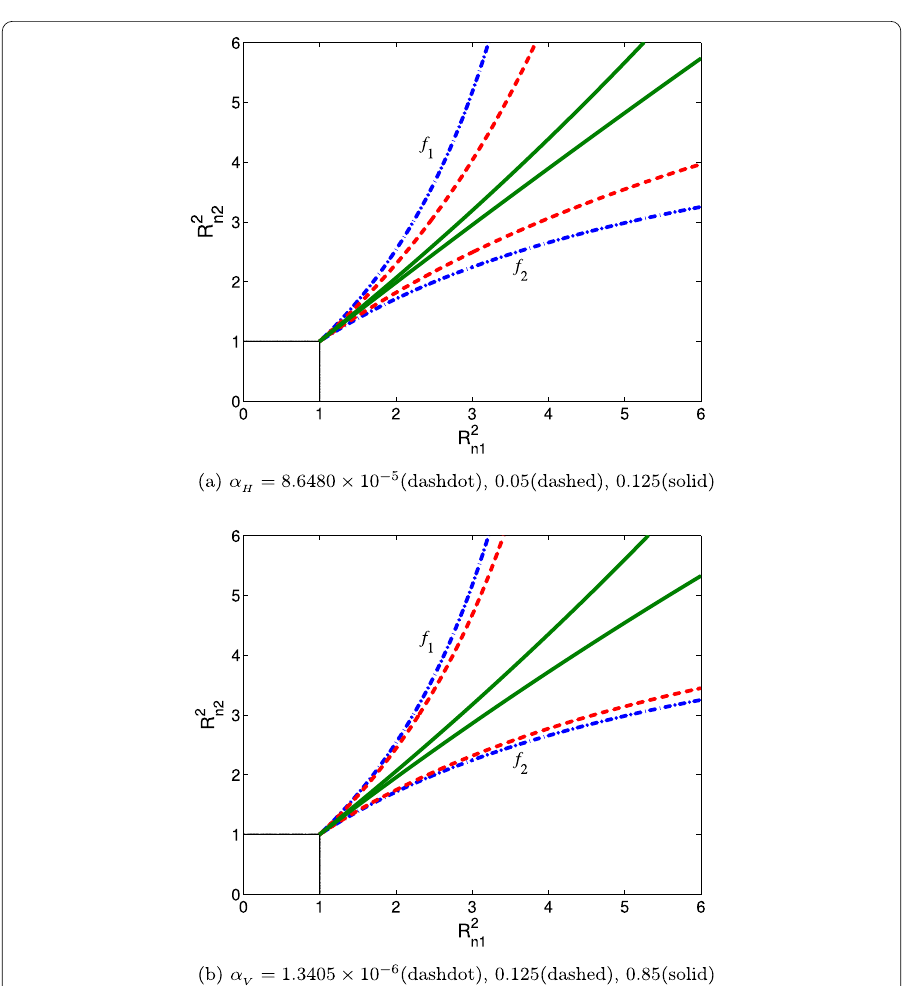
Figure 9 Showing the region of secondary infection covered by the functions f 1 and f 2 given in (4.4) with various α